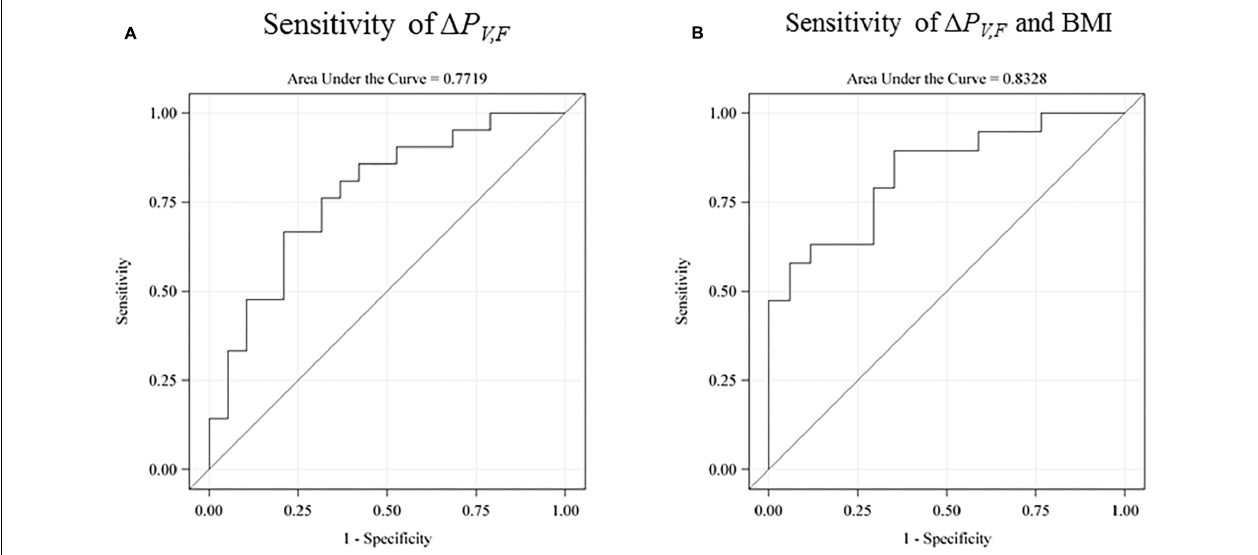
FIGURE 5 | The receiver operating characteristic (ROC) sensitivity curve of the main explanatory variable (the difference between the single-sensory and the double-sensory gamma steady state response) as a predictor of a low intelligence score (defined as below the sample mean). (A) The raw sensitivity obtained without use of any control variables. 77% (95% CI: 62–92%). (B) The sensitivity when including birth BMI. The overall sensitivity in this case is 0.83% (95% CI: 70–96%). The auditory response is not shown but has a raw sensitivity of 65% (95% CI: